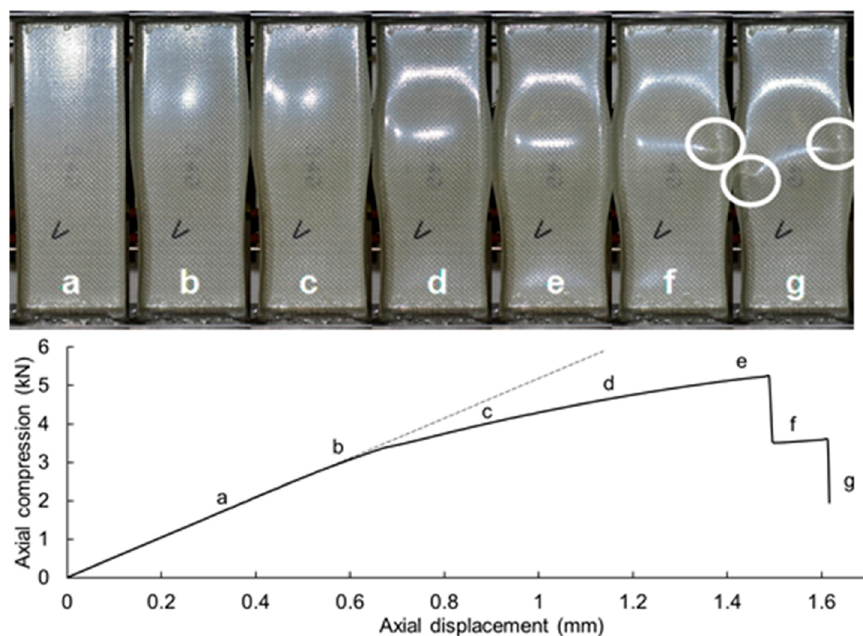
Figure 4. Exemplar glass fiber composite channel (1200 gsm) compression test (dashed line indicates the channel compression stiffness; circles indicate fractures; all column heights are 300 mm).